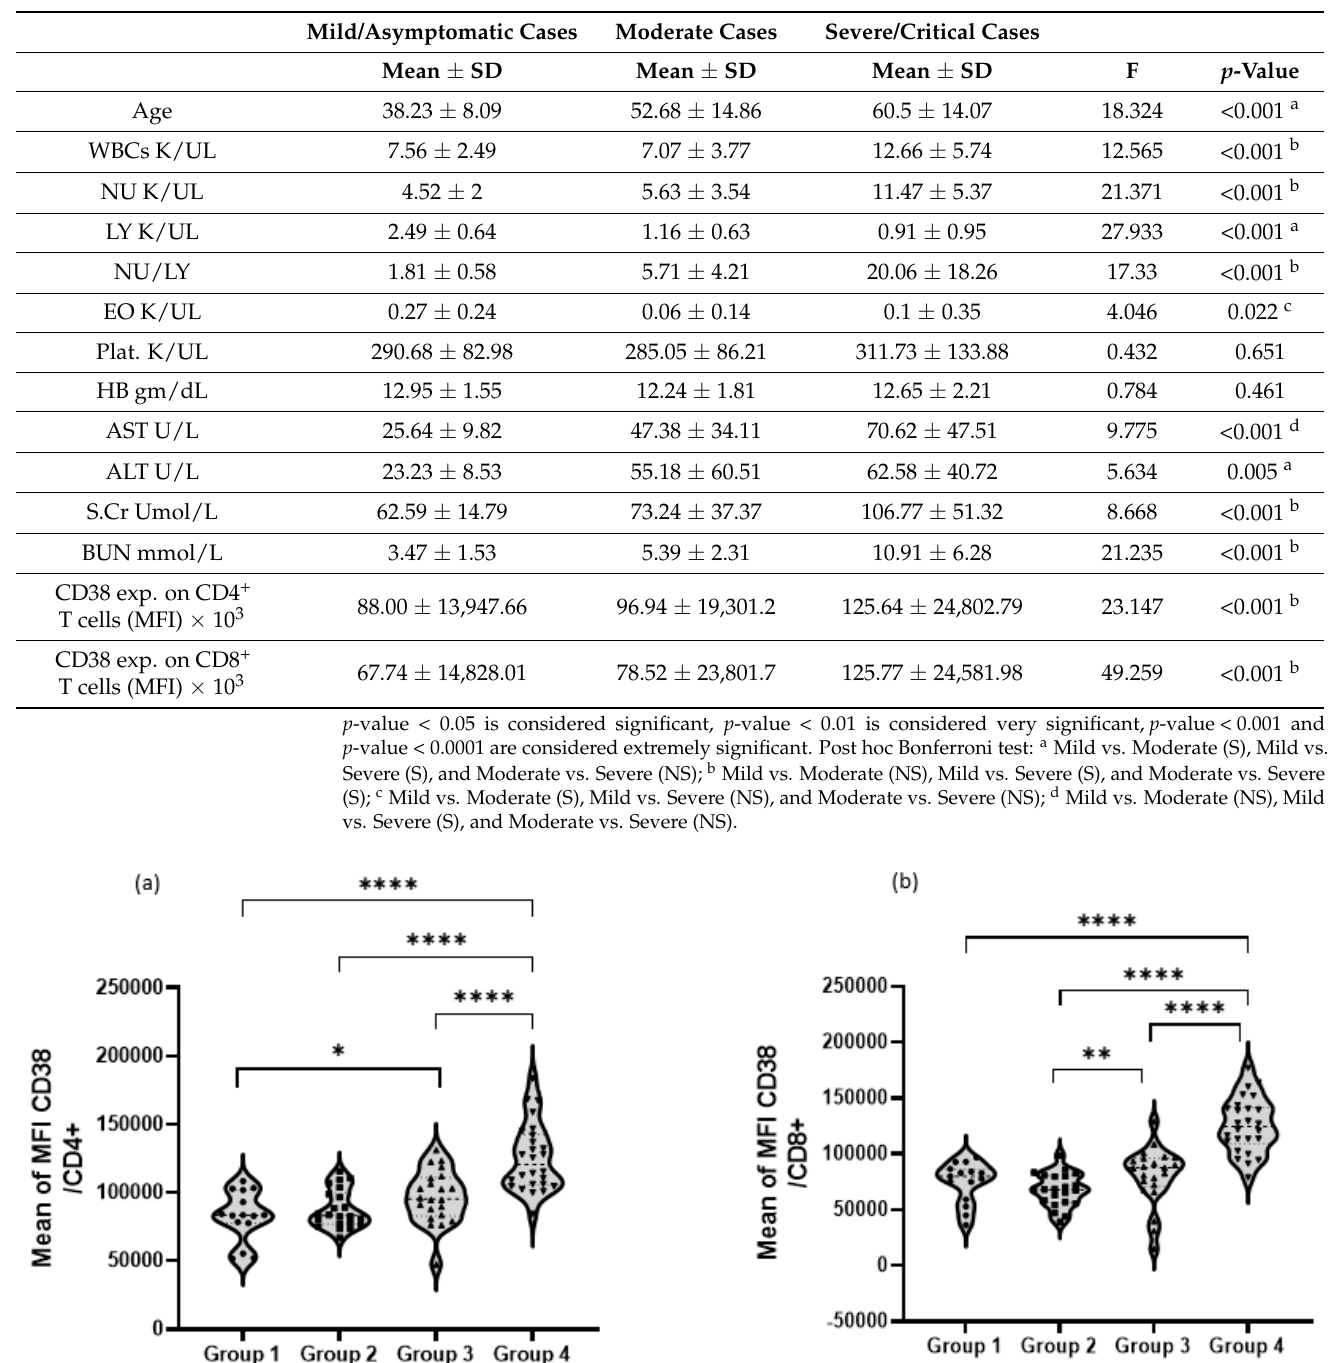
Table 5. Comparison of age, laboratory data, and CD38 expression in CD4 + T cells and CD8 + T cells between different patient groups.